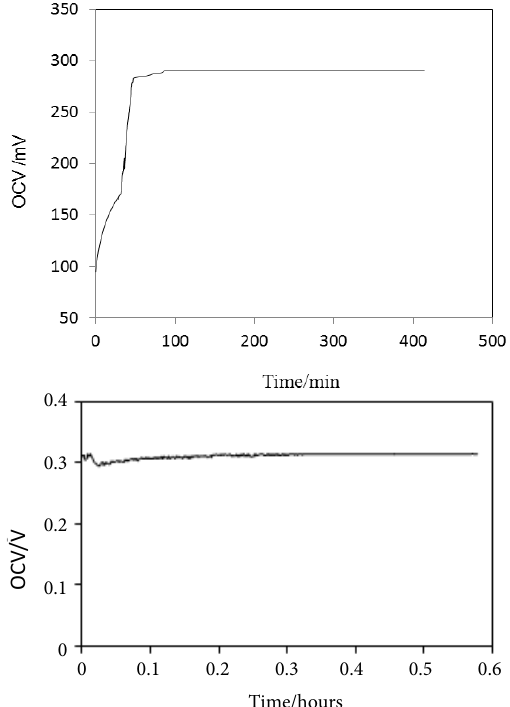
Fig. 1: OCV of BFC with bioanode GC/PMG/HOOC-MWCNT/ PDDA/ADH/PDDA and Pt/C cathode in oxygen saturated PBS (pH 7.5, 0.1M), 28ºC, 1mM ethanol and 1mM NAD + membraneless(top) and with membrane(down).